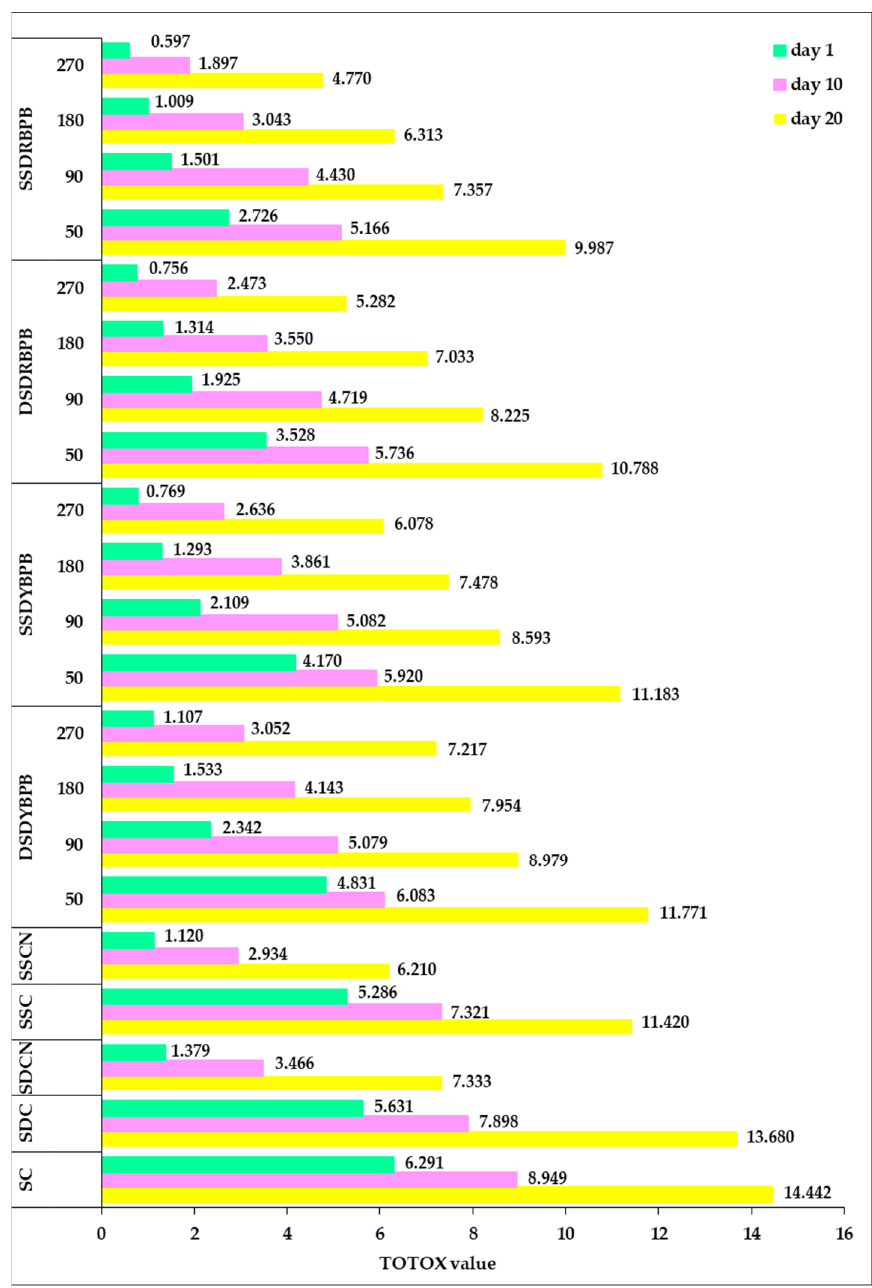
Figure 5. Effect of supplementing sausage formulas with dried bell pepper processing by-products on TOTOX value during